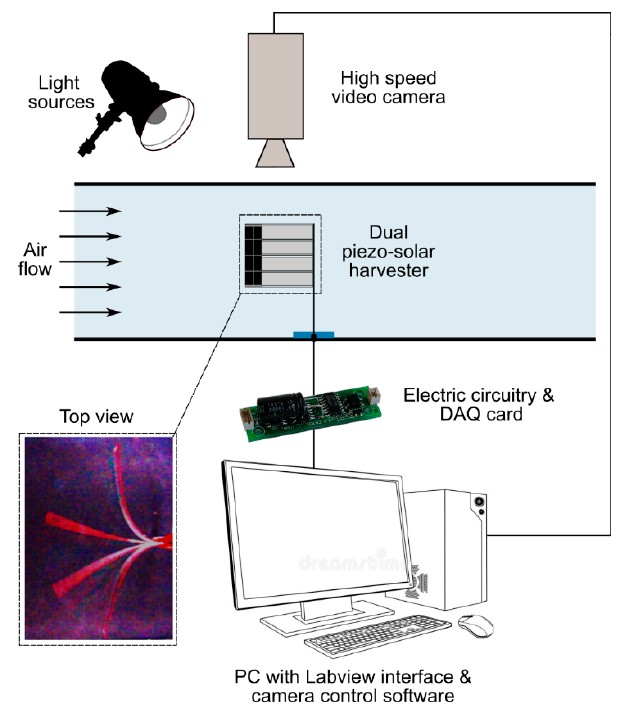
Figure 2. Schematics of the experimental set-up used to characterize the dynamics and power generation of the flags subjected to controlled wind and light excitation.